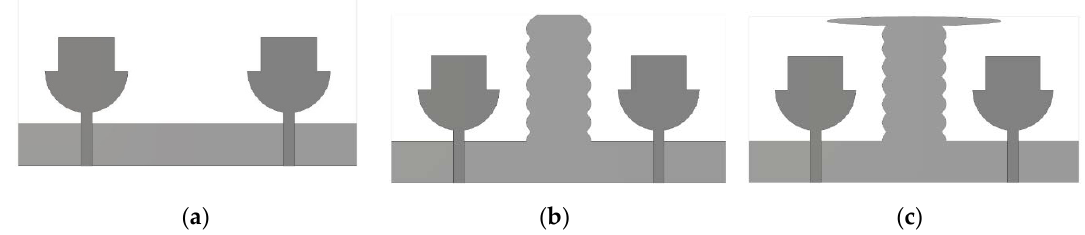
Figure 3. Design evaluation of decoupling stub in proposed MIMO antenna. ( a ) MIMO Ant1; ( b ) MIMO Ant2; and ( c ) MIMO Ant3.